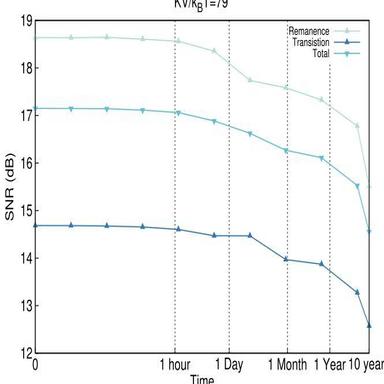
SNR obtained from multiple read back simulations performed for a HAMR system with K V /kB T = 79.